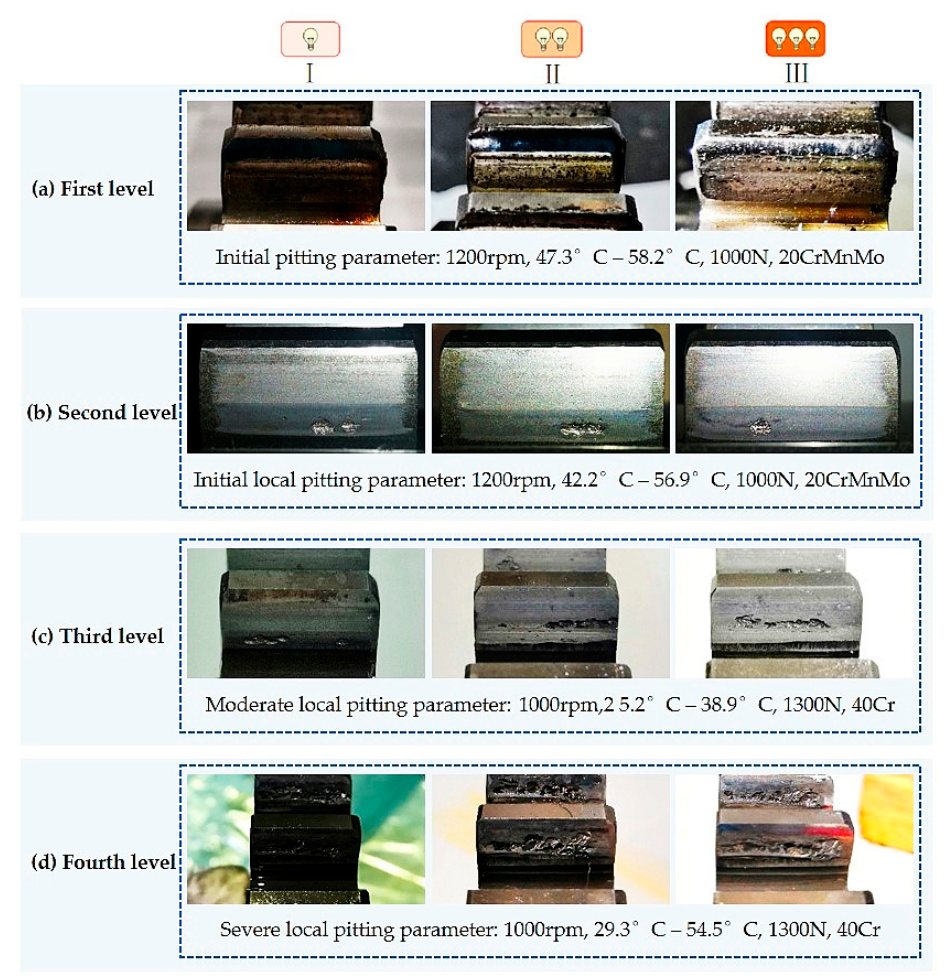
Figure 3. Gear pitting images obtained under different levels. According to the area of pitting, pitting was divided into four grades: initial pitting (first level), initial local pitting (second level), moderate local pitting (third level) and severe local pitting (fourth level).